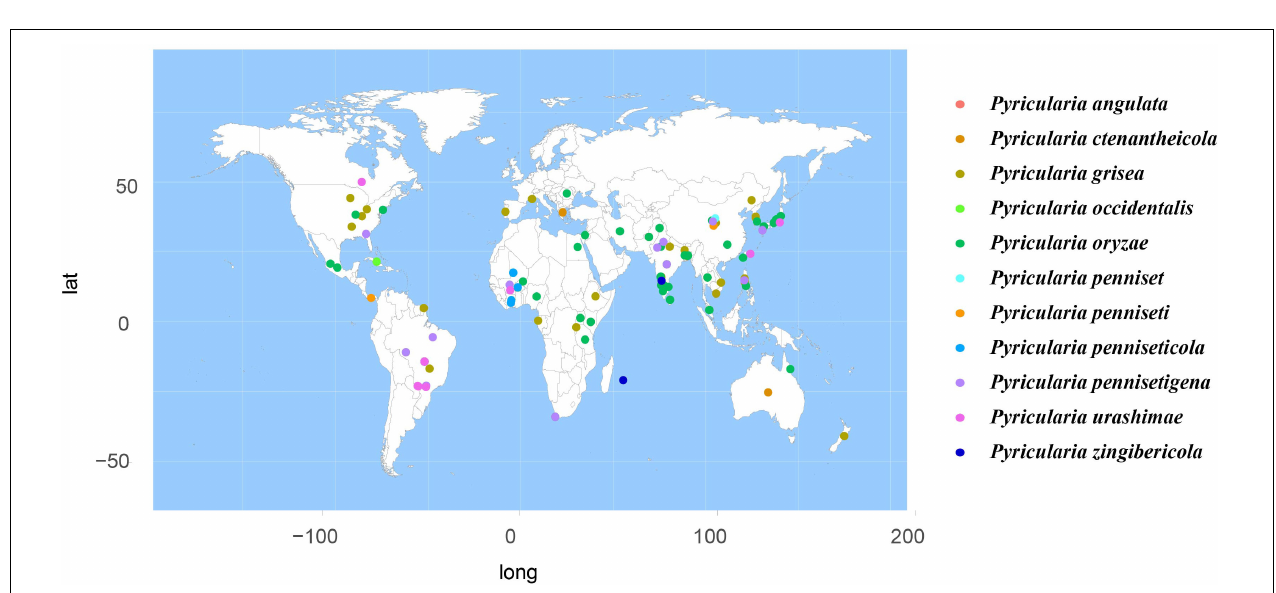
FIGURE 8 | Geographical distribution of Magnaporthiopsis using meta-analysis.